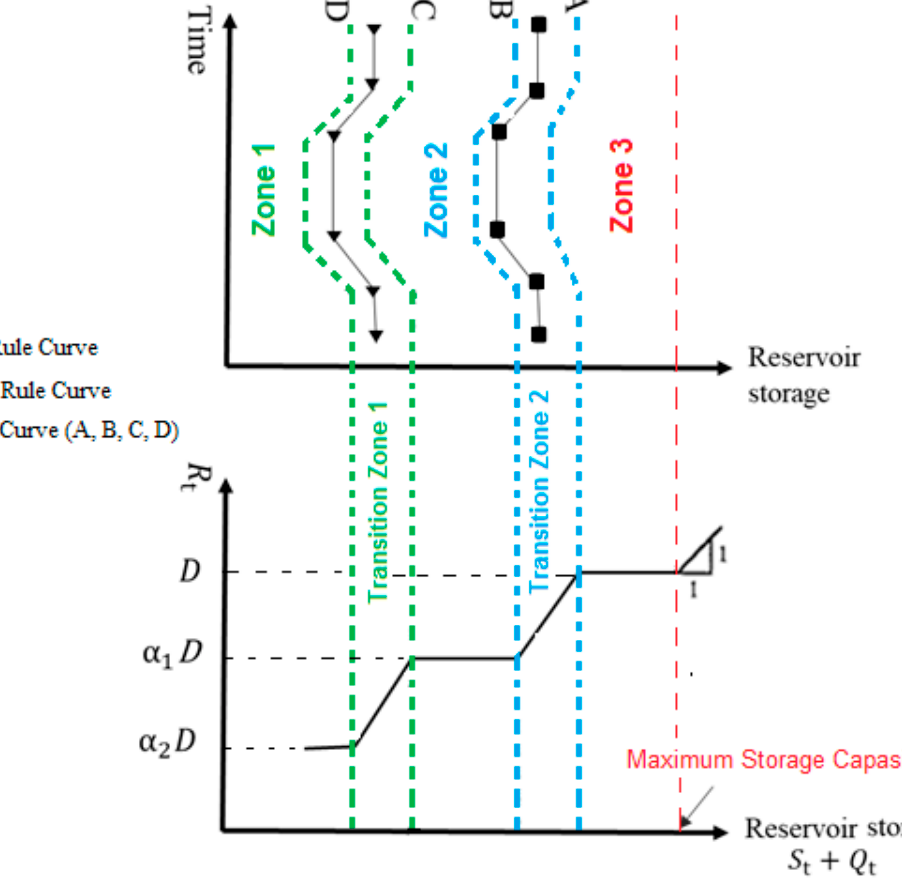
Figure 2. Schematic of the fuzzified discrete hedging rule.